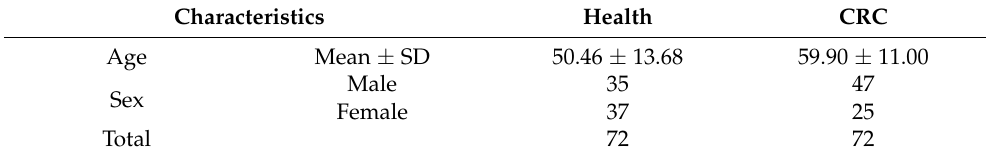
Figure A1. Knockdown experiments confirmed that HNRNPA2B1 may regulate the expression of miR-92a. ( A , B ) HNRNPA2B1 expression was successfully knocked down by si-HNRNPA2B1 transfection for 48 h in HCT116 and SW480 cells; ( C , D ) HNRNPA2B1 expression in HCT116 and SW480 cells with or without HNRNPA2B1 knockdown was measured by qRT-PCR ( n = 3); ( E , F ) miR- 92a expression in HCT116 and SW480 cells with or without HNRNPA2B1 knockdown ( n = 3), respectively. * p < 0.05; *** p < 0.001; **** p < 0.0001. Table A1. Demographic characteristics of the enrolled CRC patients and healthy volunteers.